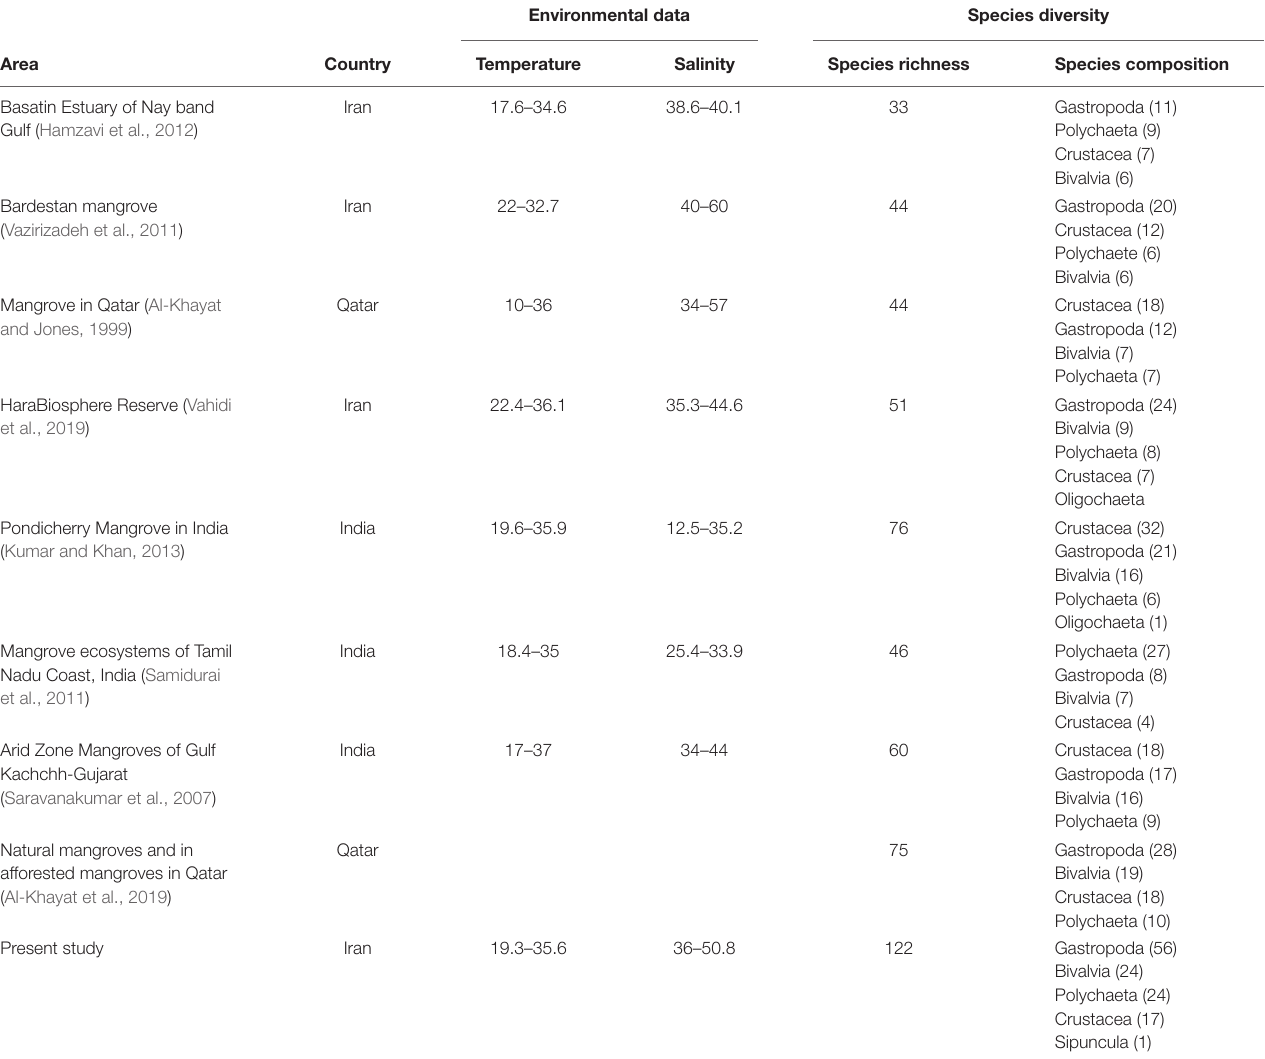
TABLE 6 | A general description of the minimum and maximum temperature and salinity, and species diversity in mangrove forests from the present and other